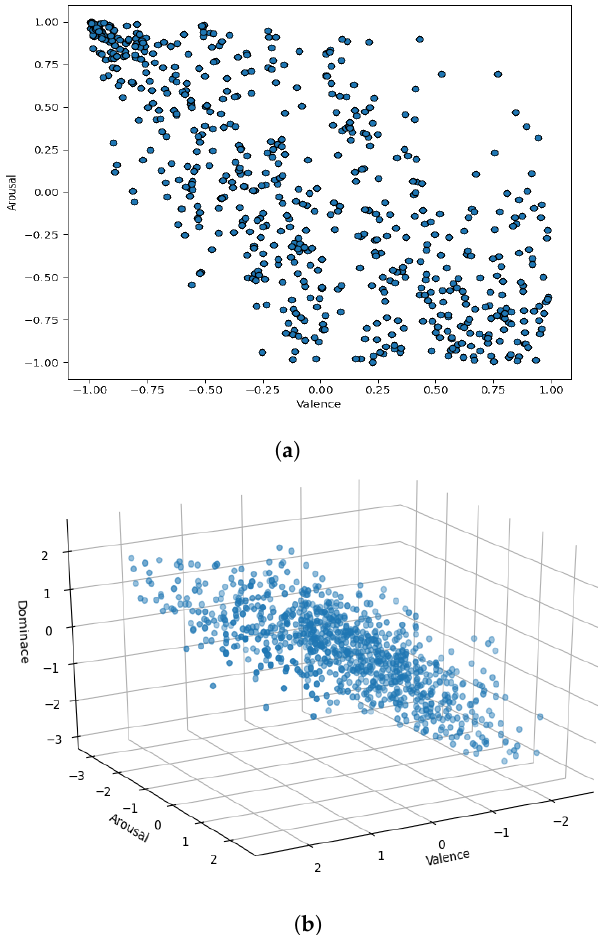
Figure 1. Visualization of EmoSoundscape and IADSE data sets. ( a ) Scatter plot of the normalized data points of EmoSoundscape in the AV space. ( b ) Scatter plot of normalized data points of IADSE in the AVD